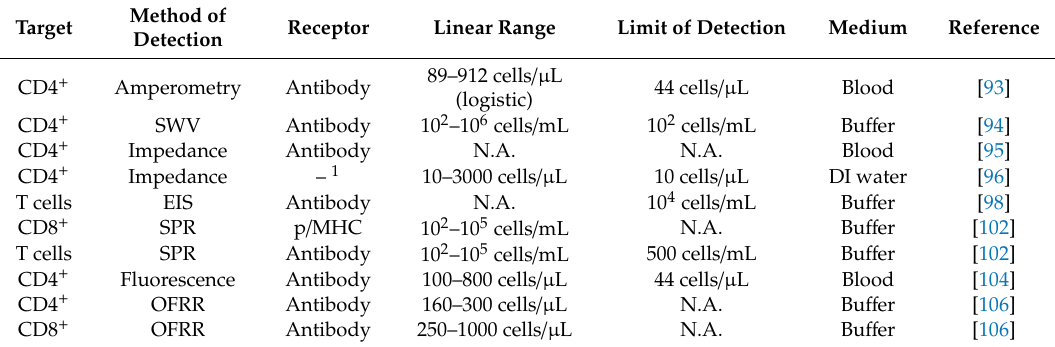
Table 5. Characteristics of the biosensors for detecting T cells (N.A., not